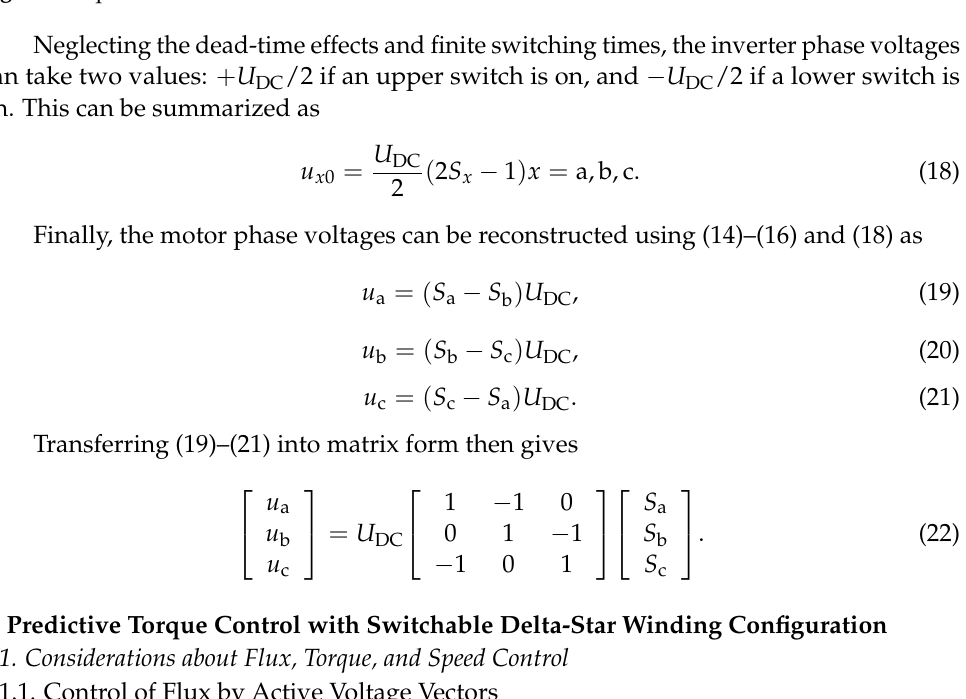
Figure 4. Equivalent circuit of the inverter and delta-connected load.